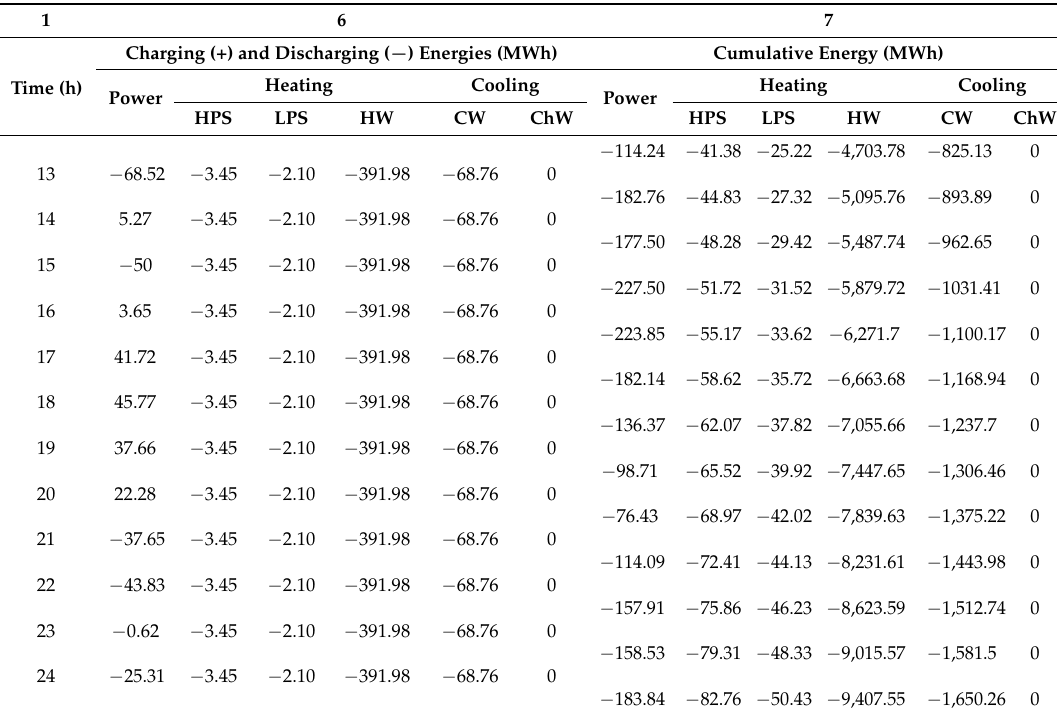
Table A6. TriGenSCA before iteration from time 13 to 24 h.